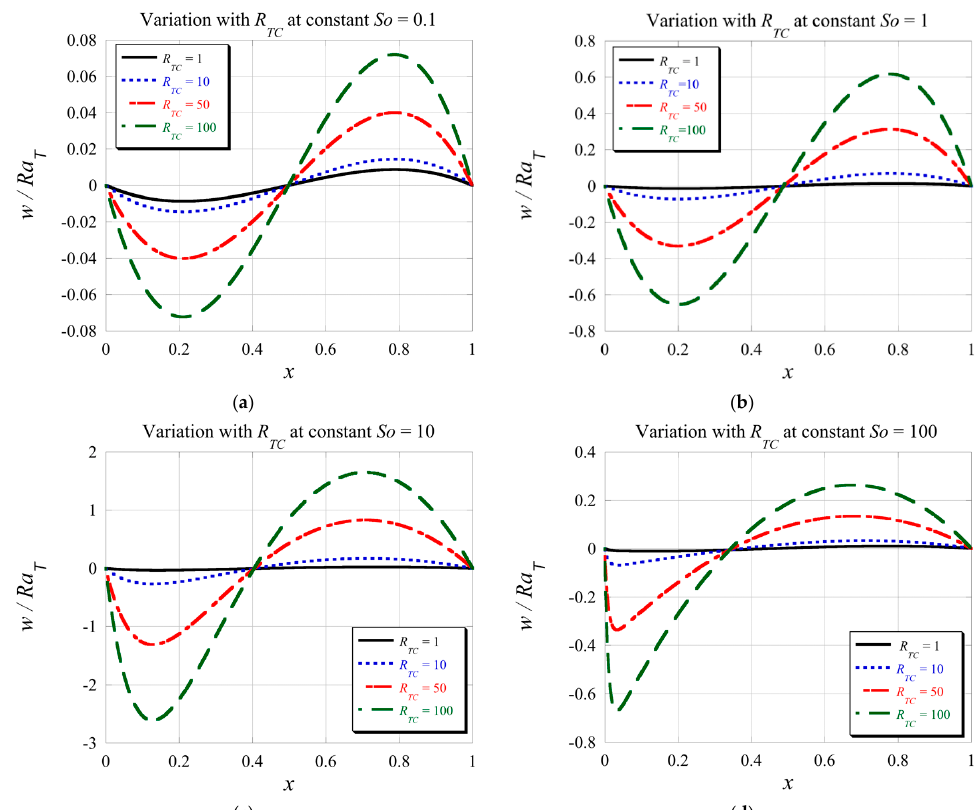
= 0.2 = 0.1 and different values of R TC : ( a ) So , ( b )